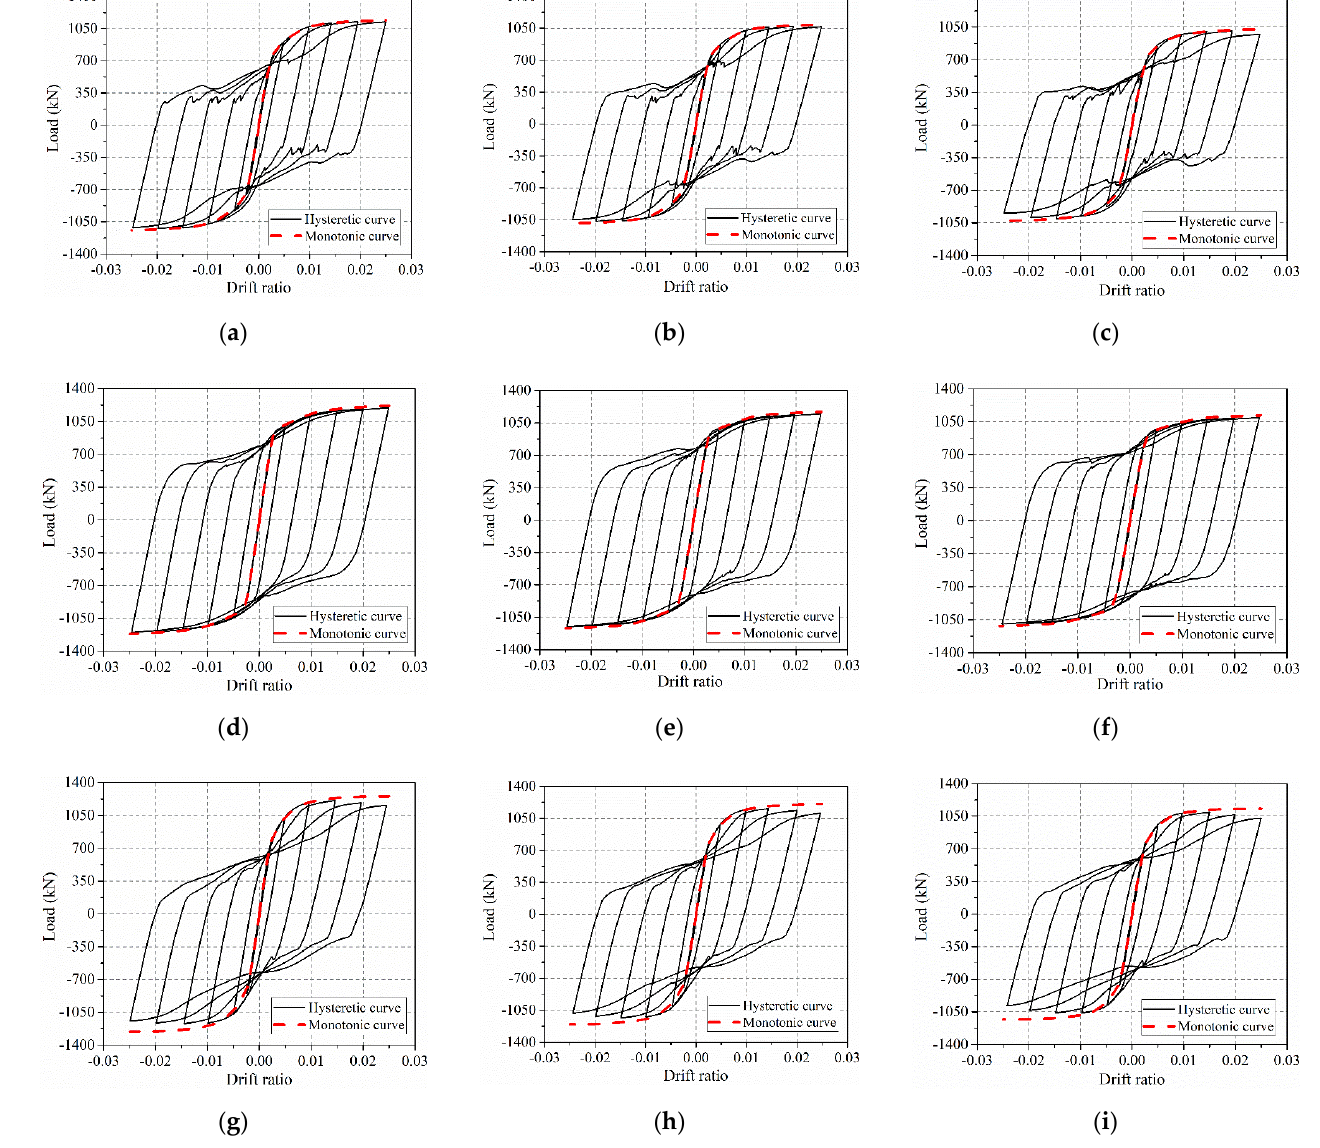
Figure 20. Hysteresis curves for: ( a ) SPSW2 − 1VHS, ( b ) SPSW3 − 1VHS, ( c ) SPSW4 − 1VHS, ( d ) SPSW2 − 3VHS, ( e ) SPSW3 − 3VHS, ( f ) SPSW4 − 3VHS, ( g ) SPSW2 − DS, ( h ) SPSW3 − DS and ( i ) SPSW4 − DS with variable column flexural stiffnesses.